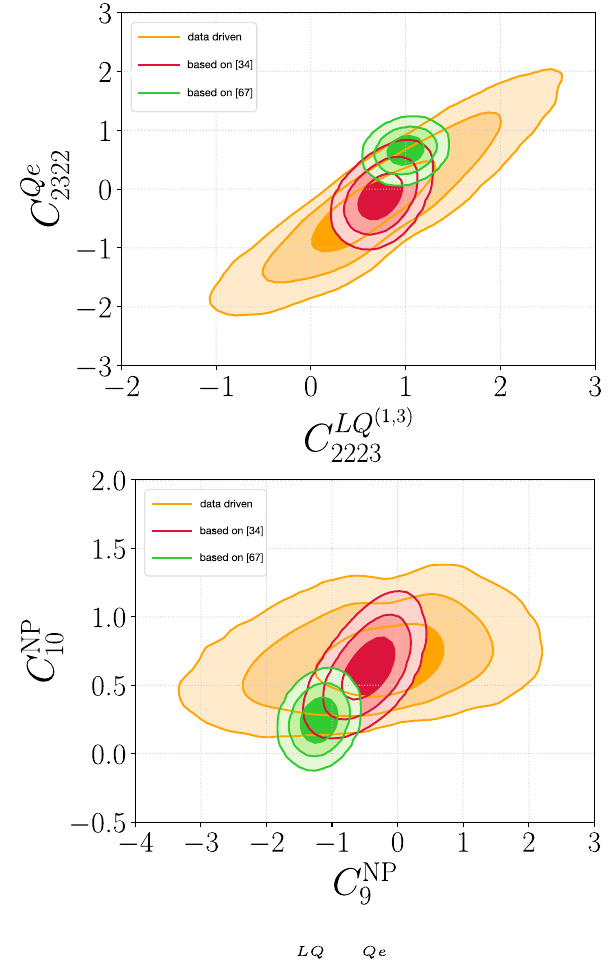
, C Qe ) plane (first panel) and in the Fig. 6 Posteriors in the ( C LQ 2223 2322 ( C NP , C NP ) plane (second panel). The colour scheme is defined in the 9 10 caption of Fig. 4. Contours correspond to smallest regions of 68.3%, 95.4% and 99.7%